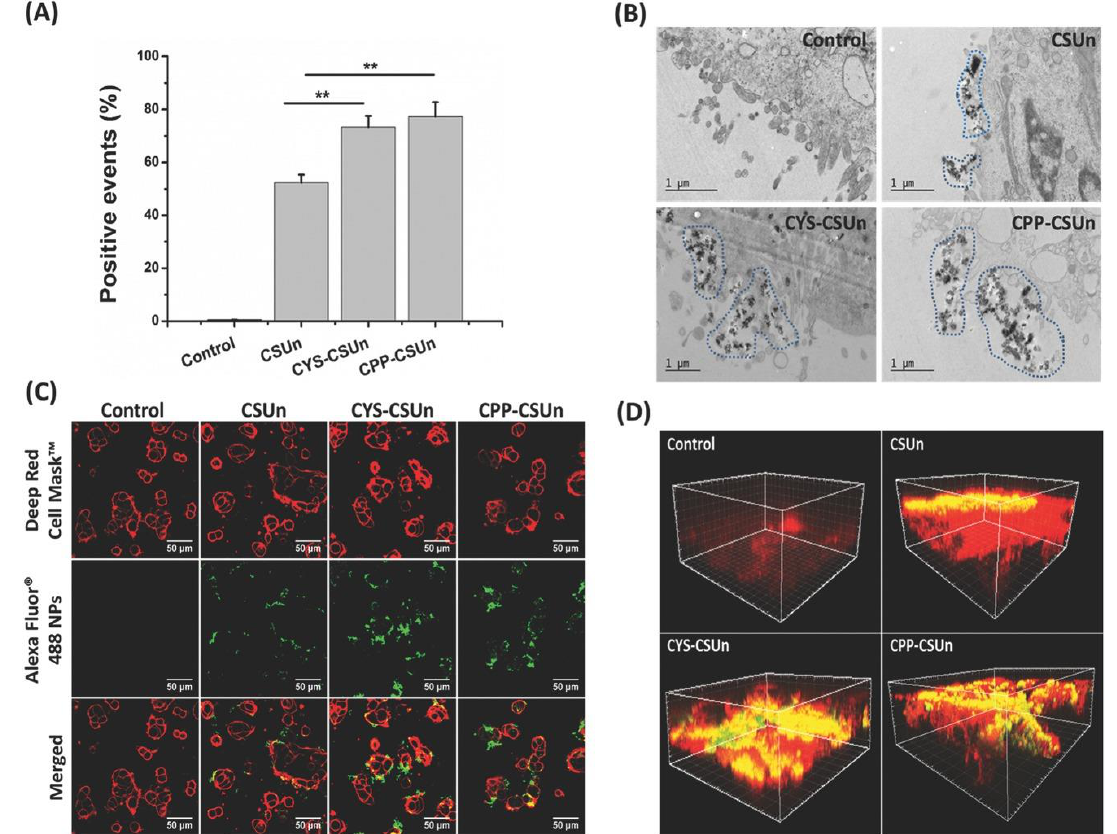
Figure 7. ( A ) Flow cytometry of cocultured Caco-2/HT29-MTX cells interacting with different silicon nanoparticles. **: the statistical significant difference ( p < 0.01) between the CSUn and CYS-CSUn or CPP-CSUn nanoparticles. ( B ) TEM images of flat embedded ultrathin sections of cell monolayers interacting with different silicon nanoparticles. ( C ) Confocal microscopy images of different AlexaFluor TM (Life Technologies, USA) conjugated silicon nanoparticles interacting with Caco-2/HT29 coculture cells after a 3 h incubation at 37 °C; Red colour indicates cell membranes stained with CellMask TM DeepRed (Life Technologies, USA); green colour indicates AlexaFluor TM conjugated nanoparticles; yellow colour indicates co-localization of nanoparticles and the cell membranes. ( D ) 3D confocal microscopy images of the cell monolayers interacting with different nanoparticles (red colour: mucus layer stained with wheat germ agglutinin (WGA)-AlexaFluor TM 594; green colour: AlexaFluor TM 488 labelled silicon nanoparticles; and yellow colour: co-localization of the mucus and the nanoparticles). Reprinted from Shrestha et al. [104] with permission of John Wiley & Sons.